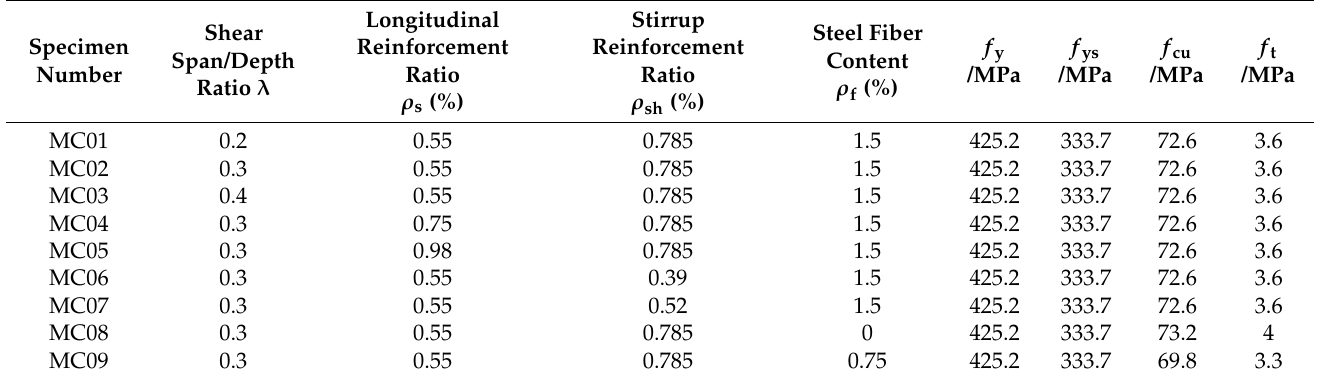
Table 1. Parameters of corbel specimens.